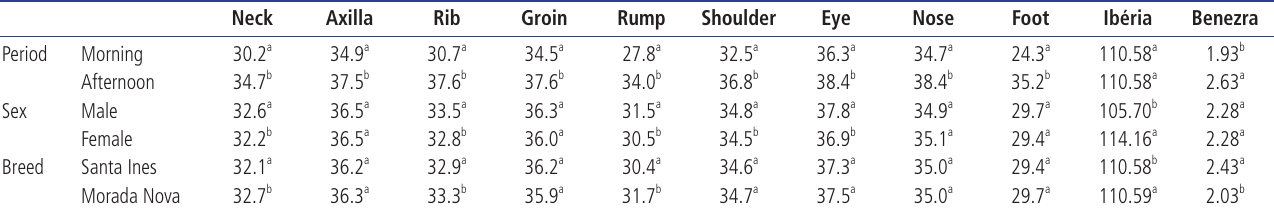
Table 4. Means for thermographic temperatures and heat tolerance indices in Santa Ines and Morada Nova sheep breeds during three days of experiment Neck